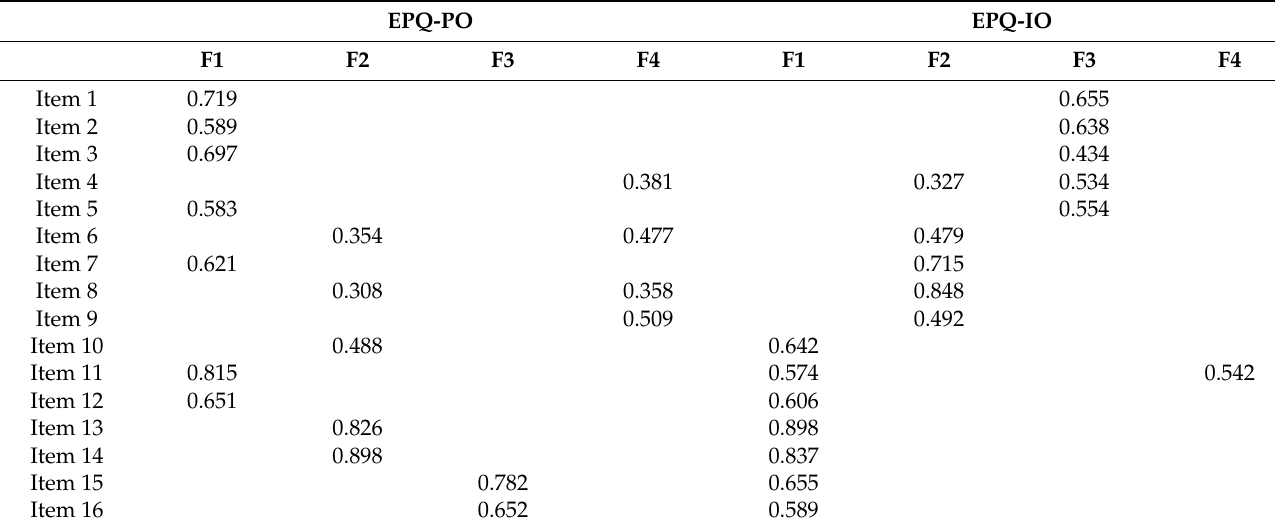
Table 5. Table factor loading for